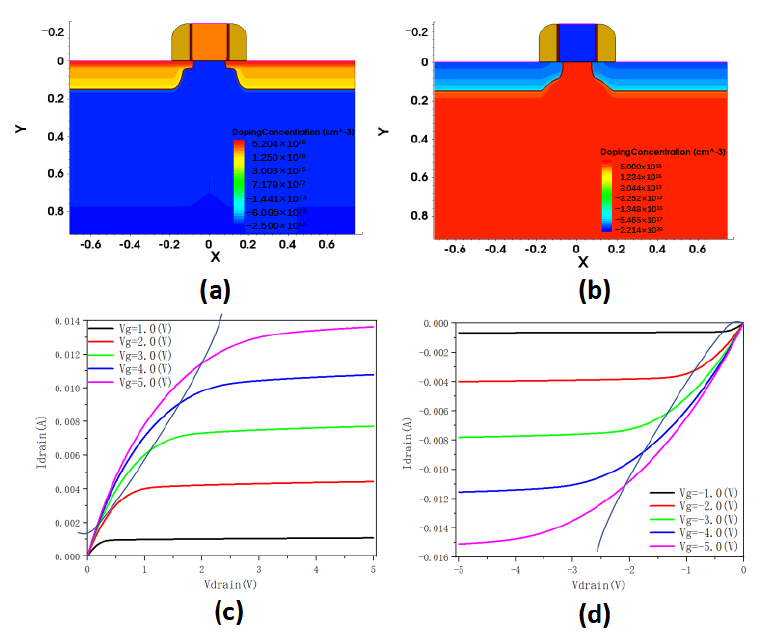
Figure 5. ( a ) NMOS model diagram; ( b ) PMOS model diagram; ( c ) NMOS output characteristic curve; ( d ) PMOS output characteristic curve.